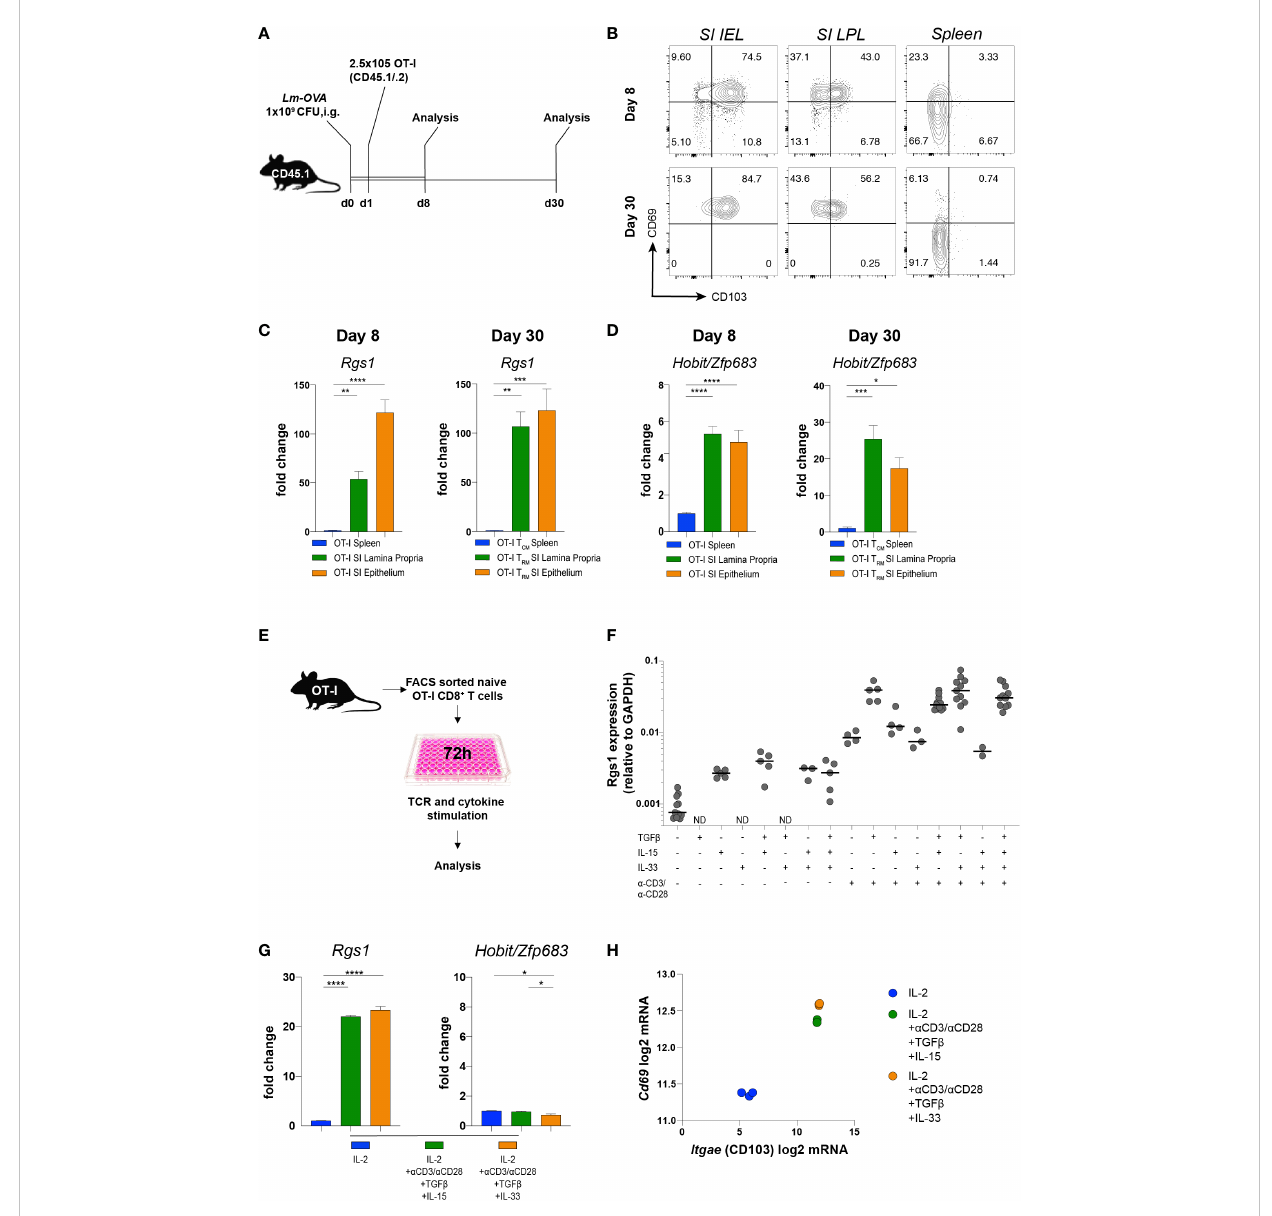
FIGURE 3 Induction of Rgs1 mRNA expression in antigen-speci fi c CD8 + T cells requires both TCR-speci fi c activation and appropriate environmental cues. (A) Experimental set-up for Figures 3B-D. (B) Representative FACS plots showing CD69 and CD103 expression on OT-I cells at day 8 and 30 post gavage with Lm-OVA in small intestinal epithelium and l. propria, and spleen. (C) Rgs1 expression and (D) Hobit/Zfp683 expression in OT-I cells isolated and FACS sorted from the spleen, SI epithelium, and lamina propria on day 8 and 30 p.i. with Lm-OVA . (n=4-8, mean ± SEM, One-way ANOVA test followed by Tukey ’ s multiple comparison test, *, p < 0.05; **, p < 0.01; ***, p < 0.001; ****, p < 0.0001). (E) Experimental set-up to optimize Rgs1 mRNA-inducing conditions in vitro . (F) OT-I T cells from the spleen of naïve OT-I tg donor mice were FACS sorted and cultured for 72h in the presence or absence of a CD3/ a CD28, TGF b , IL-15, and/or IL33 as indicated. (G) Rgs1 , Hobit/Zfp683 , and (H) Cd69 and Itgae mRNA induction in OT-I cells, cultured for 72 h under the indicated conditions. Fold change in the expression of Rgs1 and Zfp683 , mRNA upon in vitro culture vs . untreated ex vivo isolated, naïve splenic OT-I cells. (n=3, mean ± SEM, unpaired, One-way ANOVA test followed by Tukey ’ s multiple comparison test, * p < 0.05; ** p < 0.01; *** p < 0.001; **** p < 0.0001). (H) Cd69 and Itgae expression in OT-I T cells cultured in the presence of IL-2 alone, and under Rgs1 gene-inducing conditions as indicated. Experiments shown in (G) and (H) were performed twice with comparable